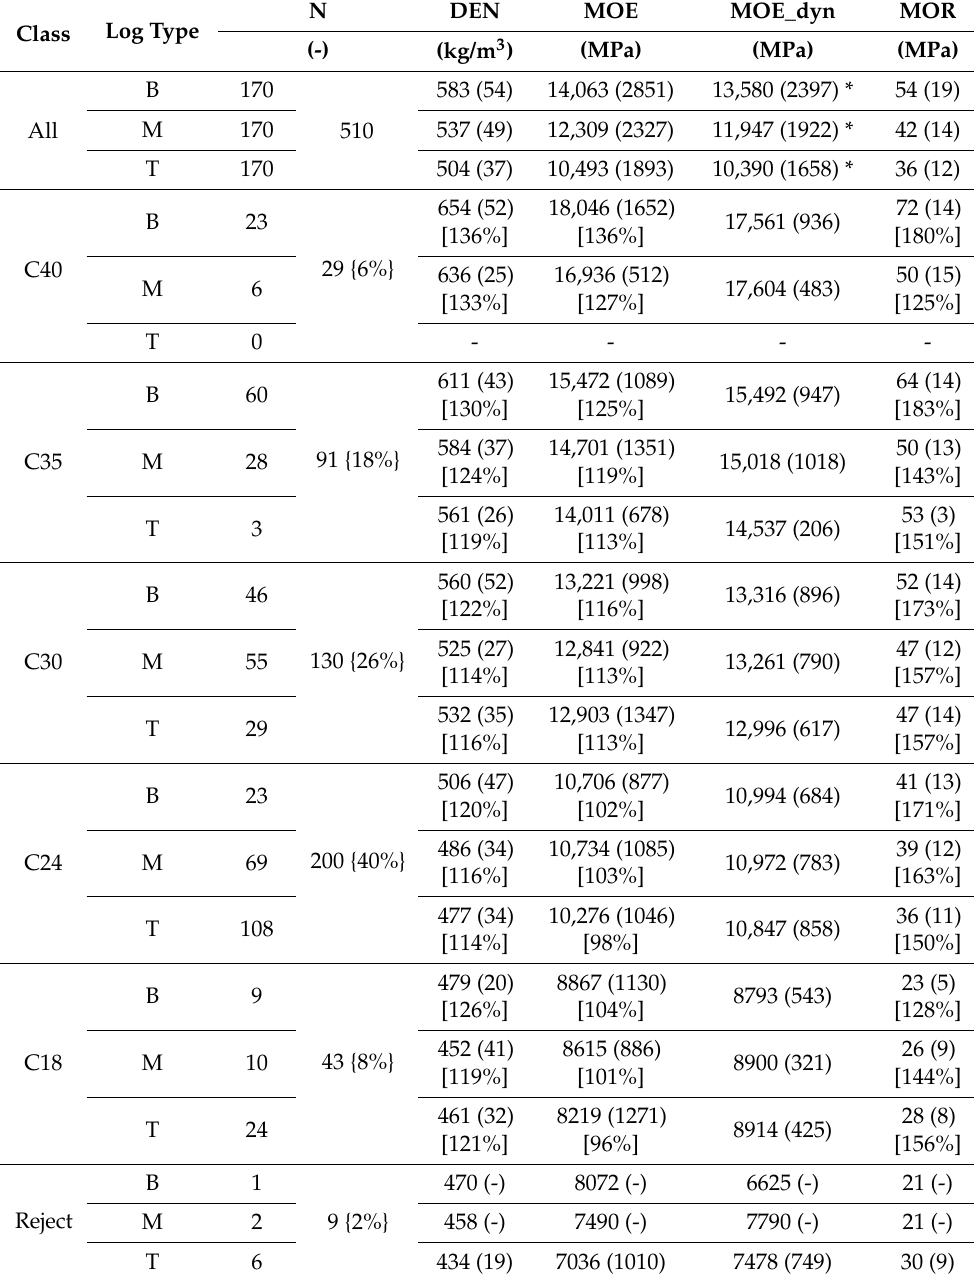
Table 1. Average values of physical and mechanical parameters (standard deviation is given in paren- theses), percentage of fulfillment of the EN 338 values are given in square brackets, DEN—density, MOE—modulus of elasticity, MOE dyn—dynamic modulus of elasticity, MOR—bending